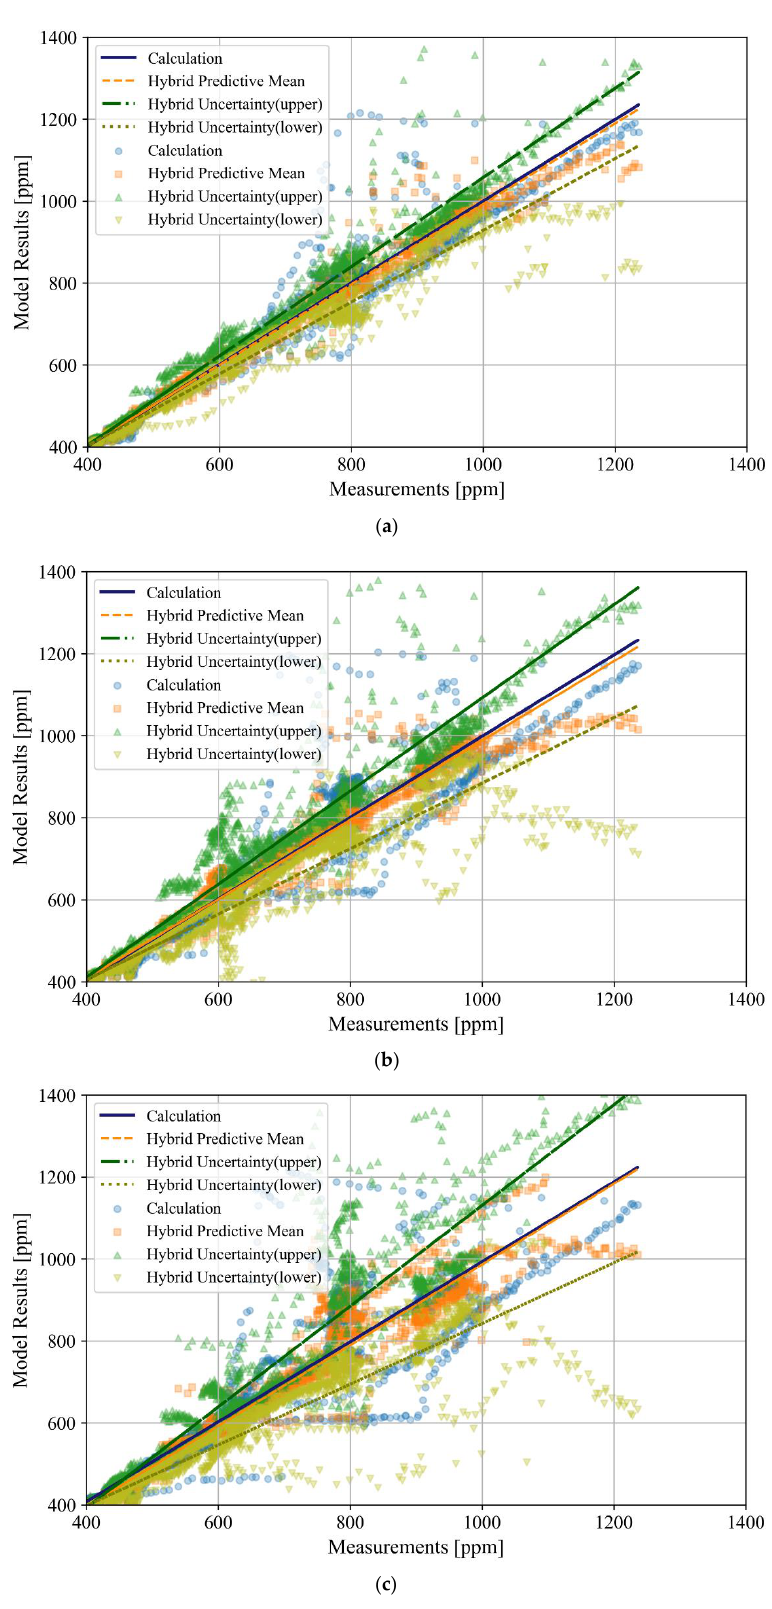
Figure 6. Scatter plot of the forecasting results obtained using the hybrid model and mass balance equation for the BR1 zone for the prediction horizons of ( a ) 5 min, ( b ) 10 min, and ( c ) 15 min.